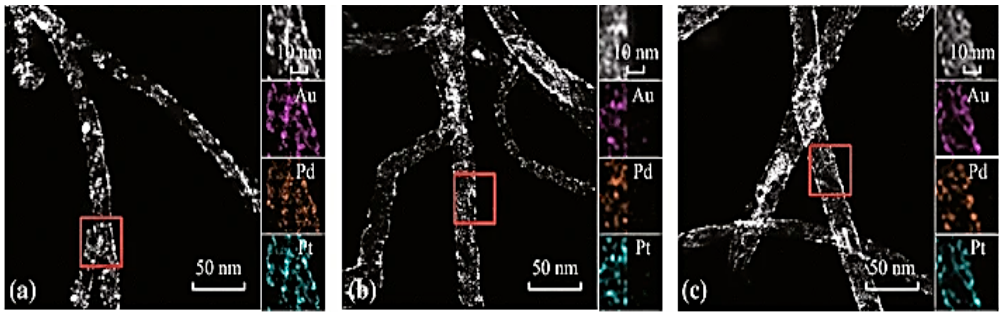
Figure 2. High ‐ angle annular dark field scanning TEM (HAADF ‐ STEM) images and regional elemental mapping of the Au, Pd, and Pt content of CNTs ‐ PdAu/Pt trimetallic NPs with different Pd/Au/Pt ratios: ( a ) 1:3:2, ( b ) 2:2:2, and ( c ) 3:1:2 Adapted from [76], (CC BY 4.0).